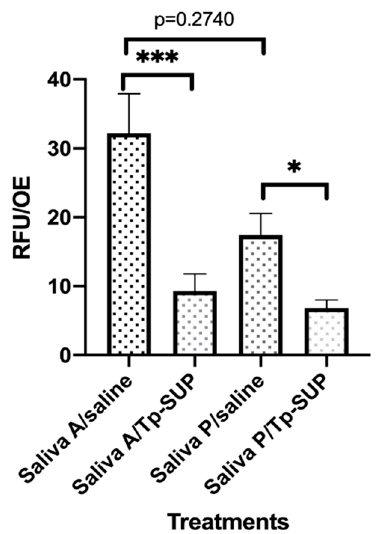
Figure 3. Biofilm persistence following Tp-SUP treatment. The saliva-contaminated OE, that had been exposed to Tp-Sup or saline (at time 23 h, for 1 h) were further incubated at 37 °C + 5% CO 2 up to 48 h in fresh medium. Then, the OE were label with CFDA for 1 h to allow fluorescence staining, washed with warm saline and transferred to new wells containing fresh medium. The plate was read by the Fluoroskan microplate reader and the fluorescence signal was recorded. The depicted values represent the mean RFU/OE ± SEM of 15 replicates obtained by 3 independent experiments. *** p < 0.001; * p ≤ 0.05.